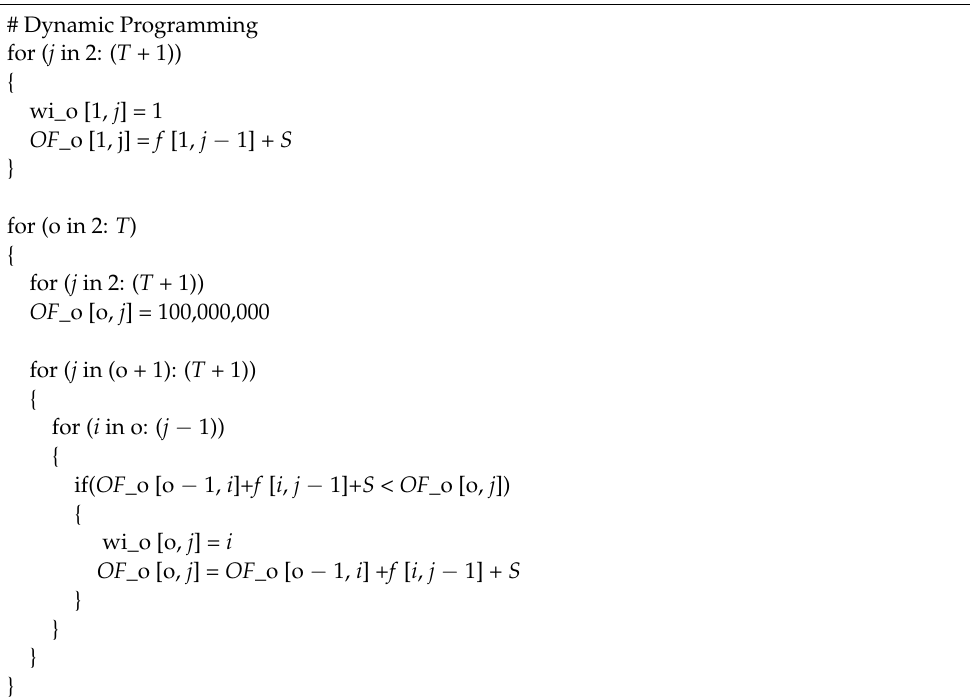
Algorithm 1. DP main part using R